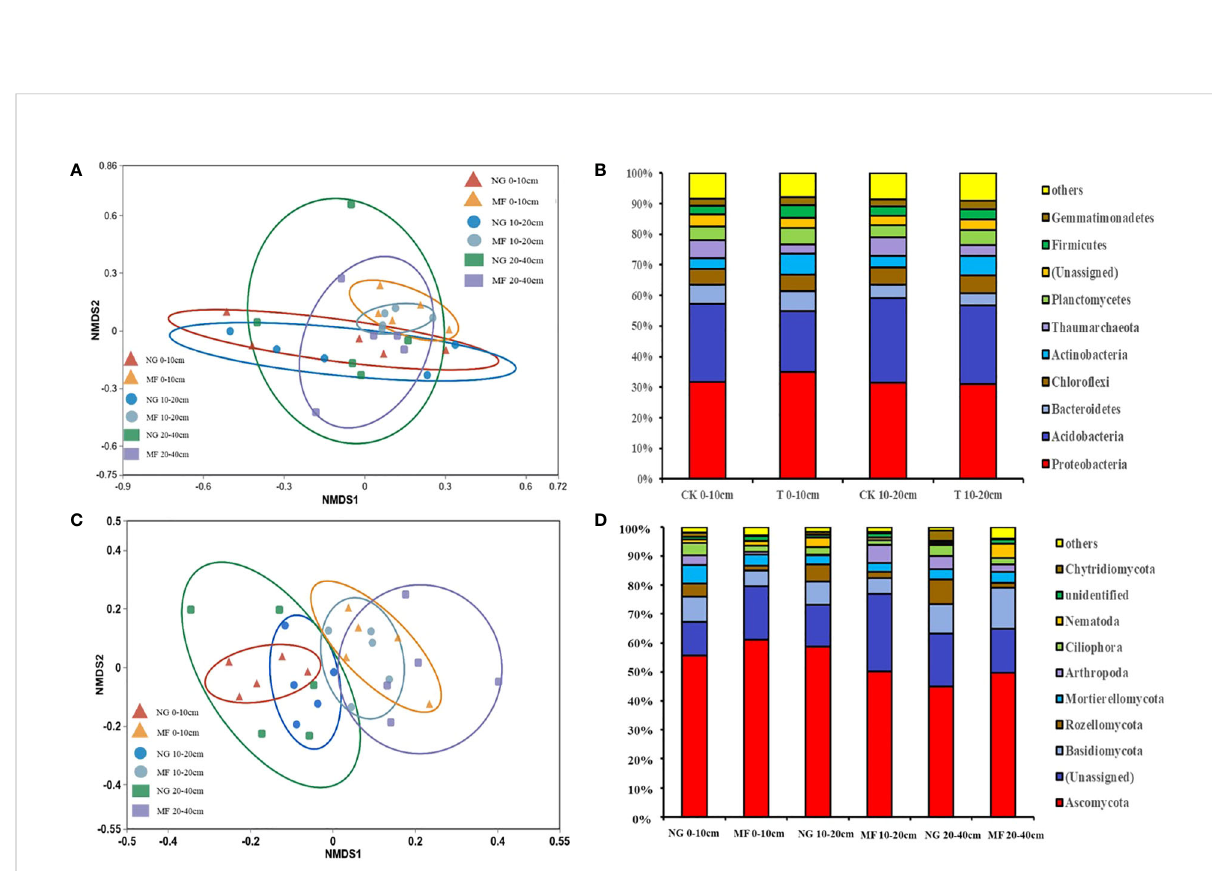
FIGURE 2 Non-metric multidimensional scaling (NMDS) based on Bray – Curtis dissimilarities (A, C) and relative abundance (B, D) of bacteria and fungi communities in different soil layers (0 – 10 cm, 10 – 20 cm, and 20 – 40 cm) of different treatments at phylum level. NG, natural grass; MF, planting ryegrass and mowing as feed. SOC, soil organic carbon; TN, total nitrogen; TP, total phosphate; AN, alkalihydrolysable N; AP, available phosphate; AK, available potassium; MBC, microbial biomass carbon; MBN, microbial biomass nitrogen; MBP, microbial biomass